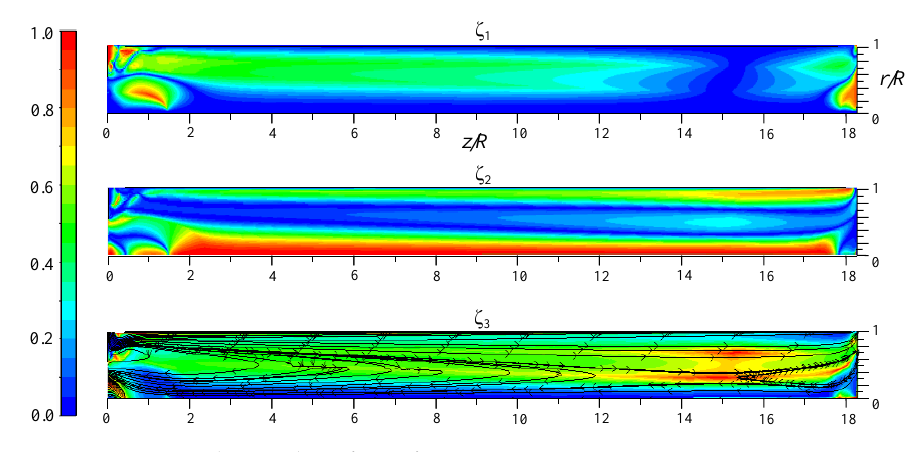
Figure 9. ζ 2 , ζ 3 , and streamlines for cmf = 0.2.